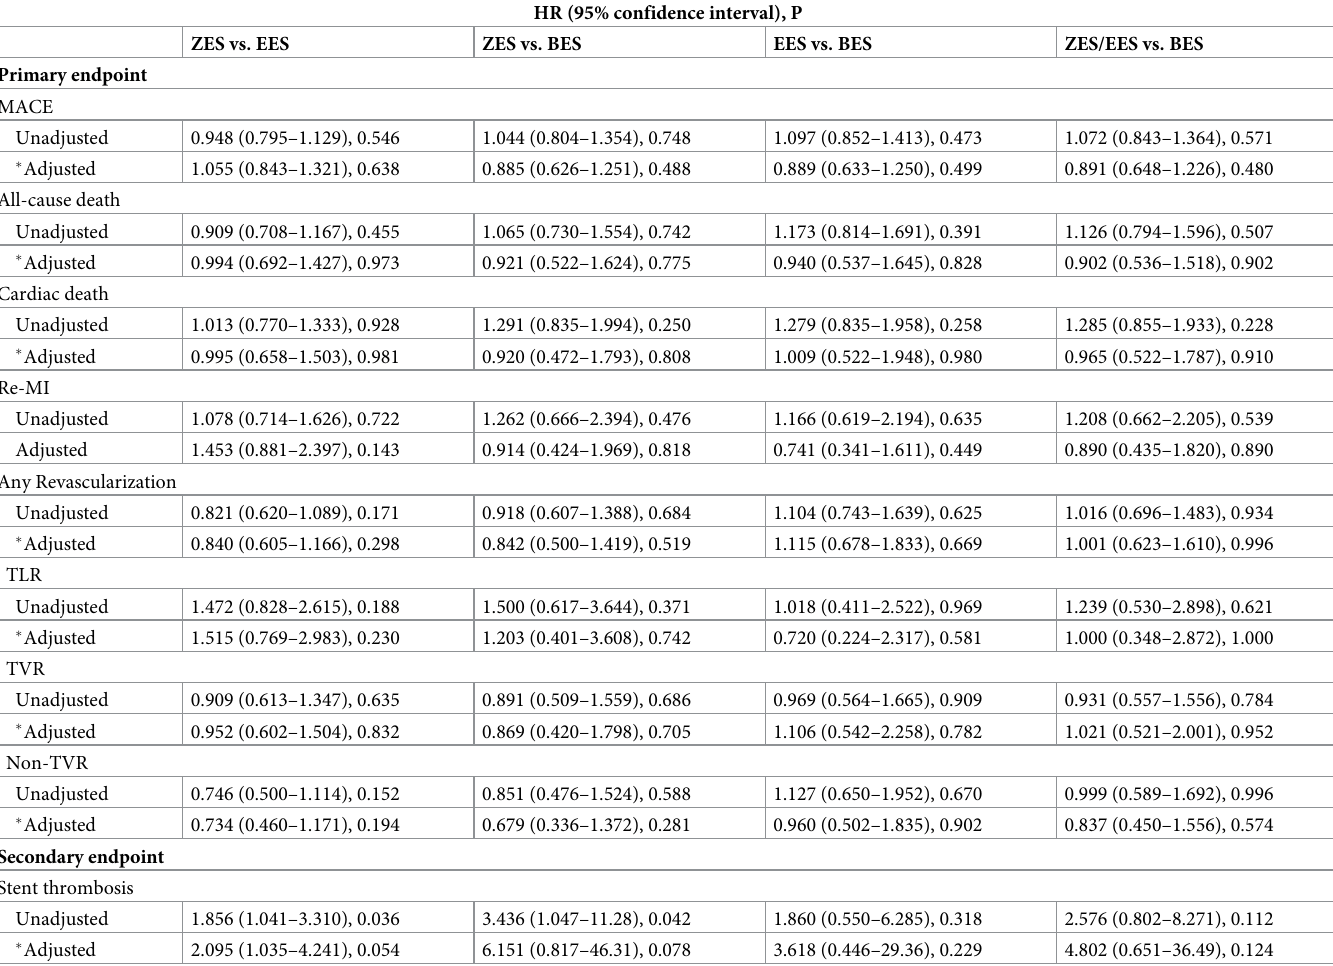
Table 3. Hazard ratio for 2-year major clinical outcomes according to the type of stent by Cox-proportional hazard ratio analysis. HR (95% confidence interval),